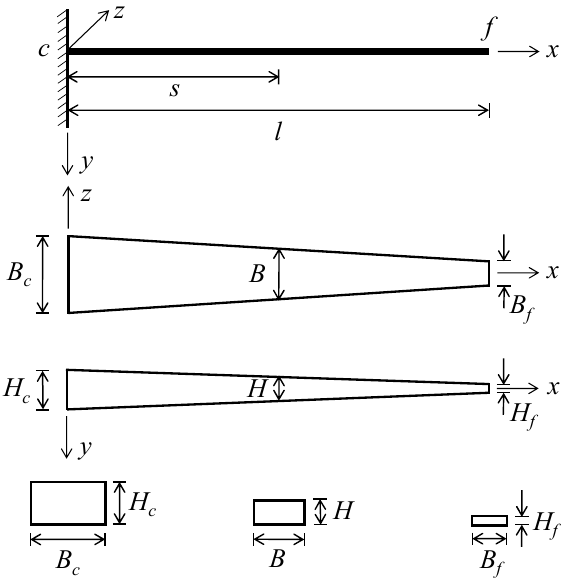
Figure 1. Geometry of the non-prismatic cantilever beam with a rectangular cross-section.